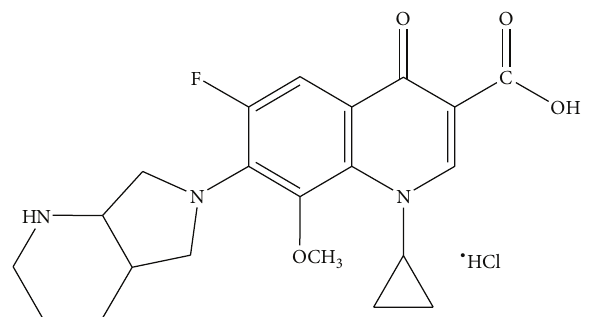
Figure 1: Moxifloxacin hydrochloride (1-cyclopropyl-7-[(S,S)-2,8- diazabicyclo[4.3.0]non-8-yl]-6-fluoro-8-methoxy-1,4-dihydro-4- oxo-3-quinoline carboxylic acid ∙